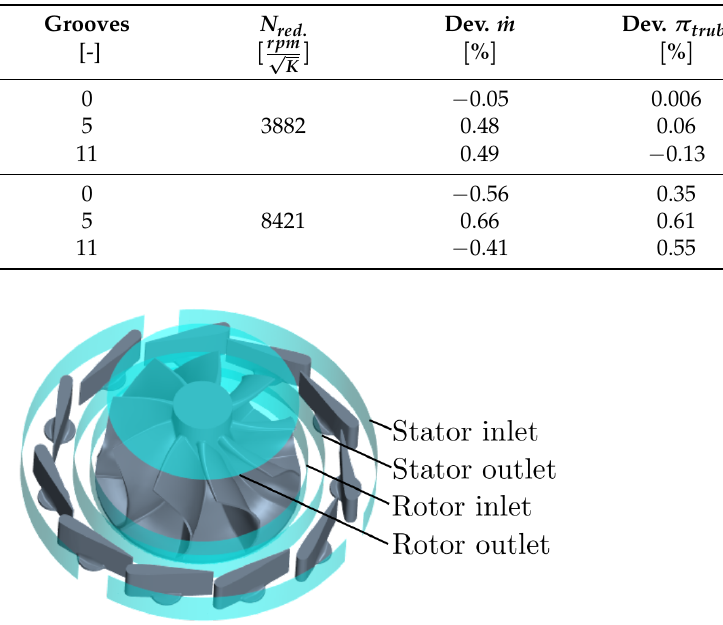
Figure 3. Selected planes to specify the inlet and outlet of the stator and